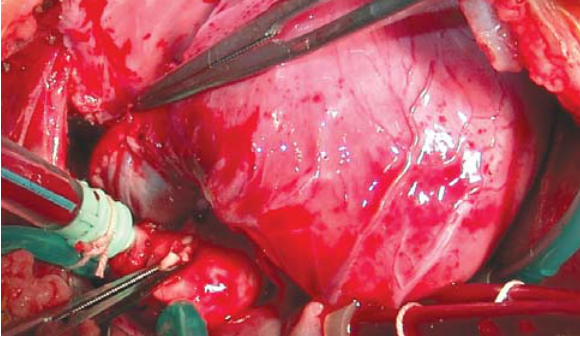
Fig. 4 – Aspecto final com a face aórtica reconstruída com sutura direta e pulmonar com pericárdio autólogo fresco